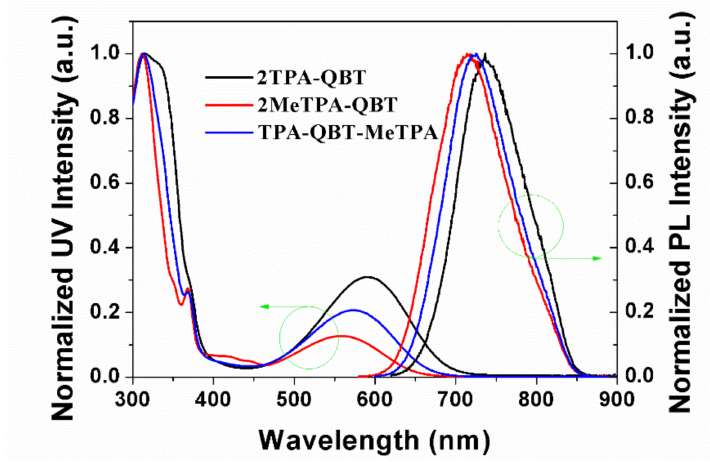
Figure 4. Ultraviolet-visible absorption and photoluminescence spectra for 2TPA-QBT , 2MeTPA- QBT and TPA-QBT-MeTPA in toluene solution.